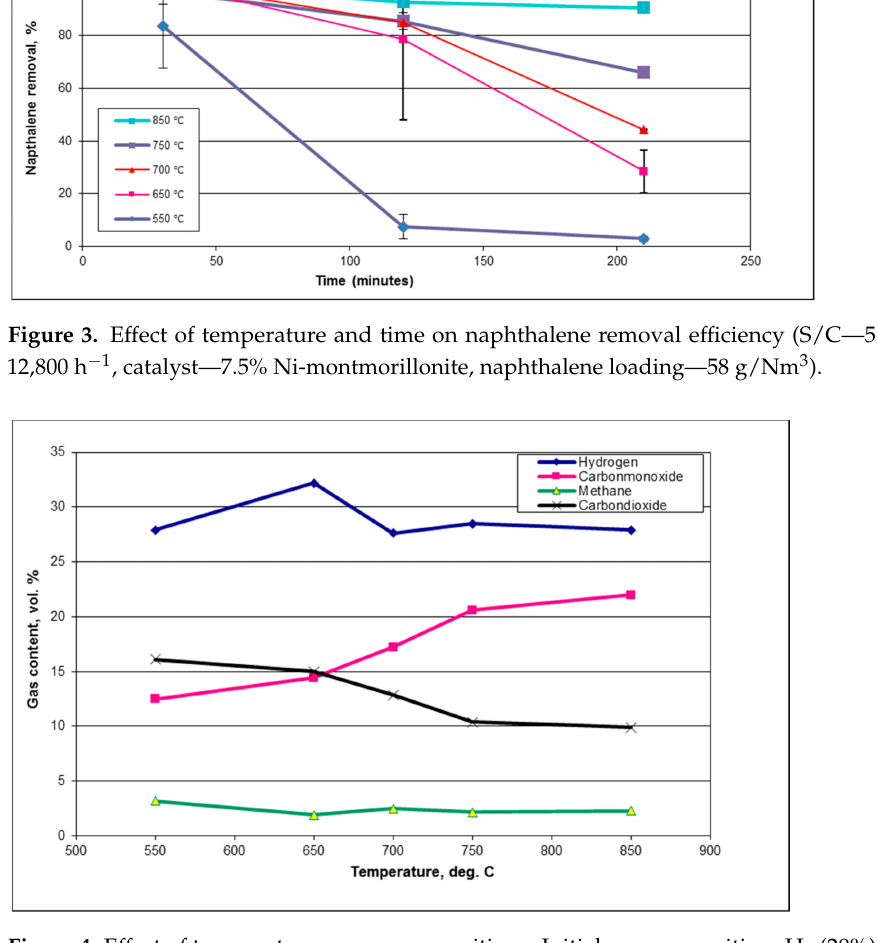
Figure 4. Effect of temperature on gas compositions. Initial gas composition: H 2 (20%), CO (20%), CO 2 (10%), CH 4 (3%) (S/C—5.0, GHSV—12,800 h − 1 , catalyst—7.5% Ni-montmorillonite, naphtha- lene loading—58 g/Nm 3